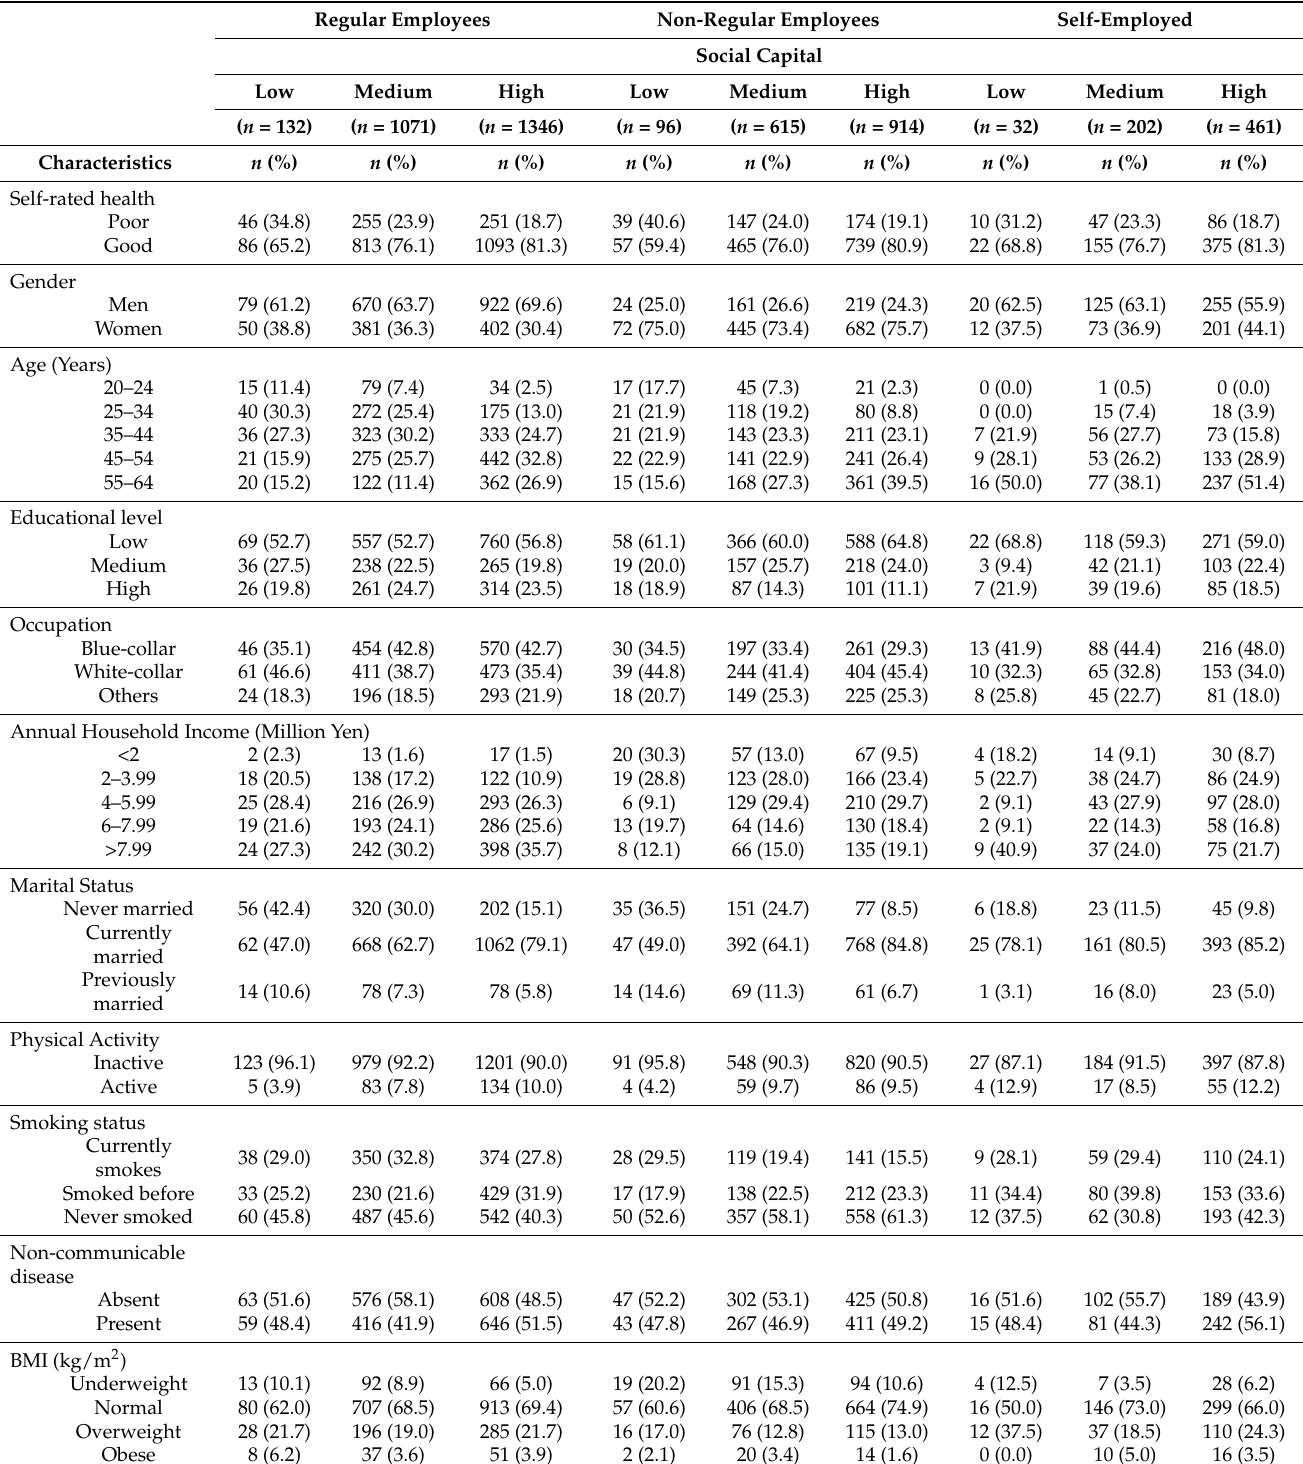
Table 2. Characteristics distribution of respondents among social capital groups based on their employment